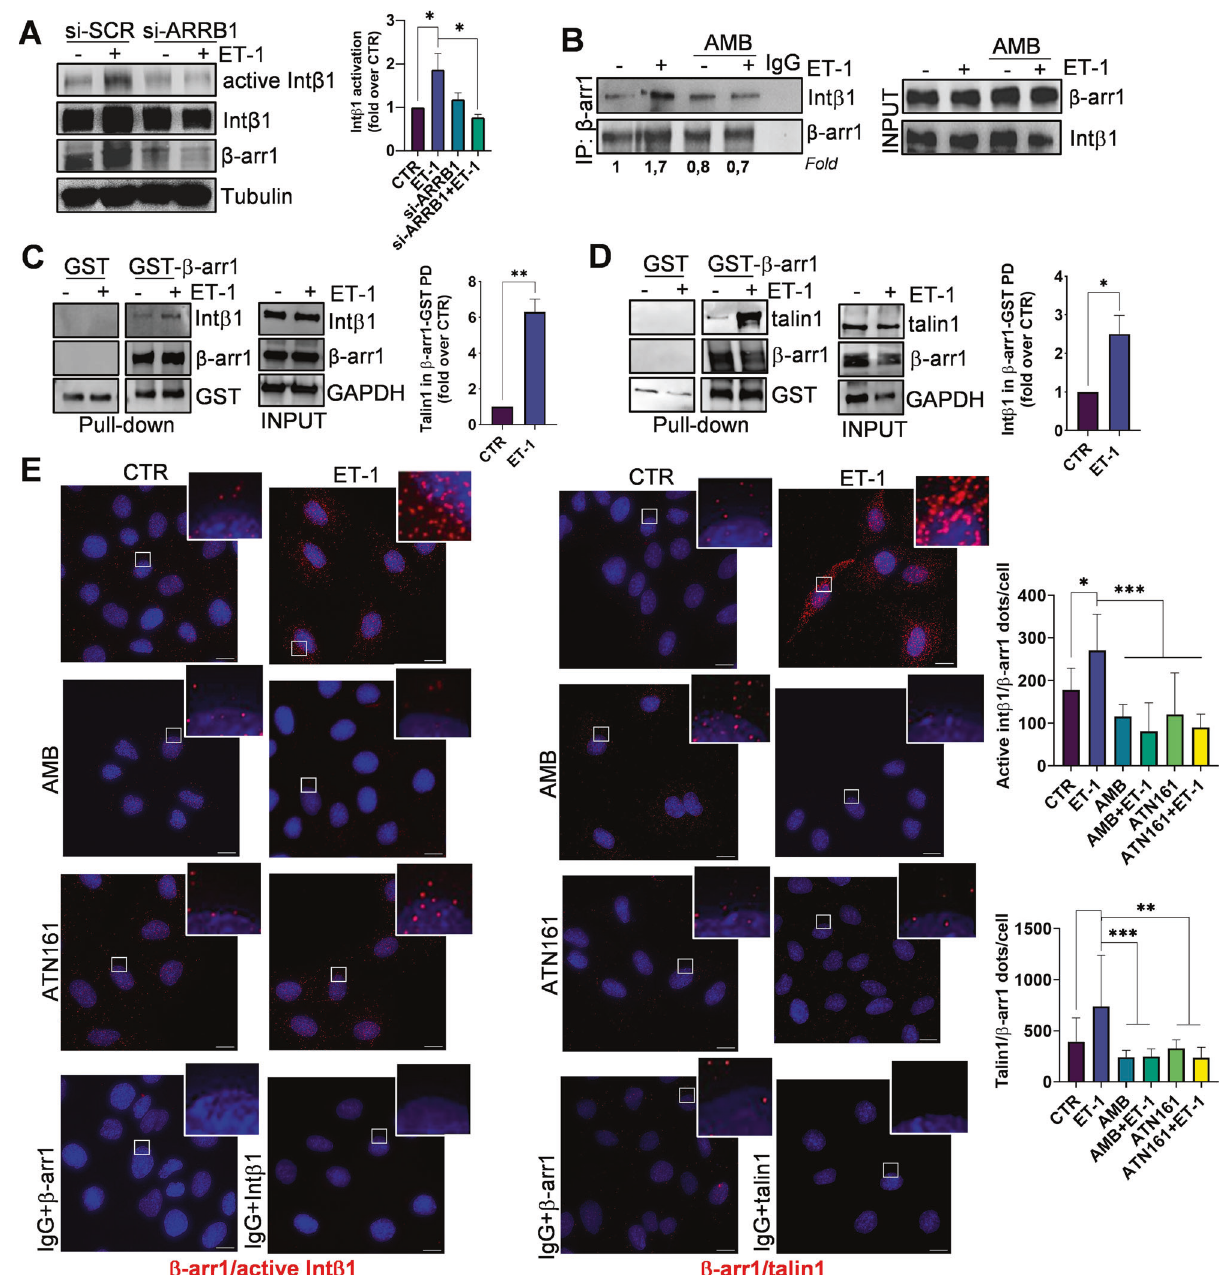
Fig. 5 β -arr1 links Int β 1 and talin1. A si-SCR and si-ARRB1 transfected SKOV3 cells, stimulated with ET-1 for 5 min, were subjected to WB for indicated proteins. Histograms mean ± SD of the average band intensity normalized to Tubulin used as a loading control (fold changes versus CTR); n = 2, one-way ANOVA. B Lysates of SKOV3 cells stimulated with ET-1 and/or AMB for 5 min were immunoprecipitated (IP) with anti- β -arr1 or irrelevant IgG. C , D Lysates of OVCAR3 cells stimulated or not with ET-1 were incubated with GST or GST- β -arr1 fusion protein. Representative images of inputs and pulldown analyzed by WB for indicated proteins. Histograms, means ± SD of the average band intensity normalized to GAPDH used as a loading control (fold changes versus CTR); n = 2, t test. E Representative PLA images of protein complexes containing Int β 1 and β -arr1 or talin1 and β -arr1 in OVCAR3 cells stimulated with ET-1 and/or AMB and/or ATN161 for 60 min. The red signal represents a positive PLA reaction and DAPI staining (blue) highlights the nucleus. No positive PLA reaction was observed in negative controls (with primary antibodies and irrelevant IgG). Scale bar, 10 μ m. Inset, show higher magni fi cations of the square. Histograms mean ± SD of PLA dots per nucleus; n = 3. One-way ANOVA, Tukey post hoc analysis. 500- μ m thick containing fi bronectin/type I collagen gels. Cells ET-1/ β -arr1/Int β 1 signaling regulates cell invasion in the adhered to and invaded these gels, and the addition of ET-1 organotypic model signi fi cantly enhanced the average invasion depth into the ECM, To assess the requirement of ET-1-dependent Int α 5 β 1 signaling for whereas this effect was almost lost when cells were treated with the ability of cancer cells to invade, we performed a test using a 3D AMB, ATN161 and upon silencing of talin1 or β -arr1 (Fig. 7A). matrix invasion assay in which cancer cells were seeded on top of a